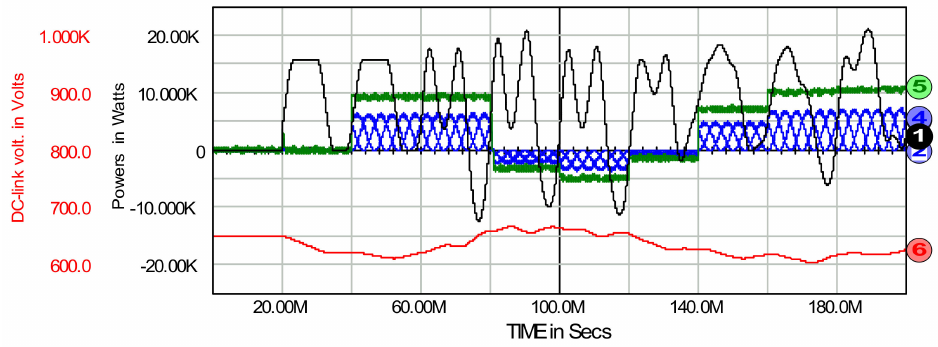
Figure 10. Total instantaneous load power: waveform 1 (in black); instantaneous source phase powers: waveforms 2, 3, and 4 (all in blue); three-phase source total power: waveform 5; DC-link capacitor voltage: waveform